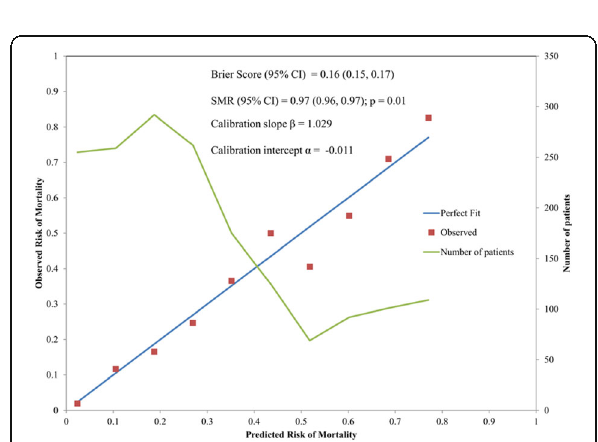
Fig. 4 (abstract P5). Calibration curve comparing between observed and predicted mortality at each cut-point of THAI-ICU